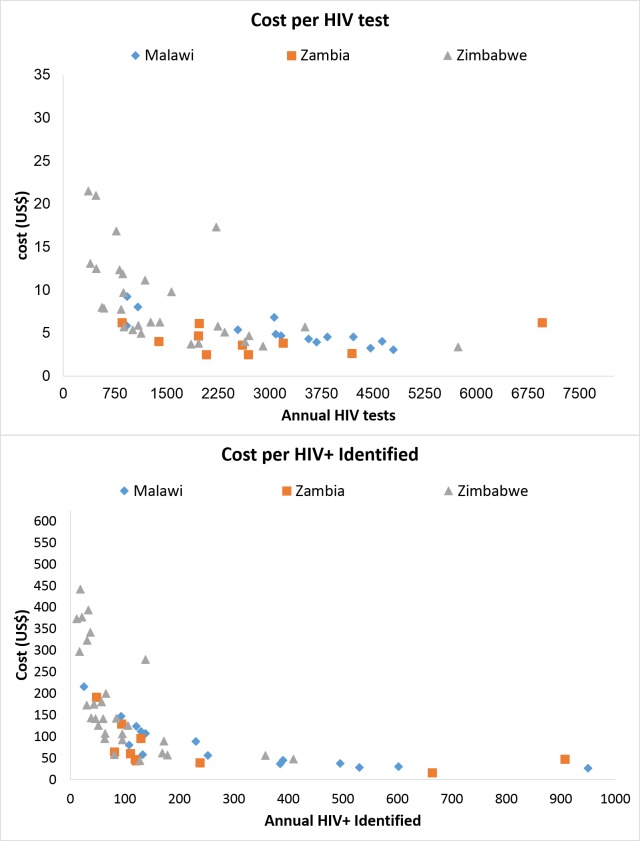
Economies of scale.